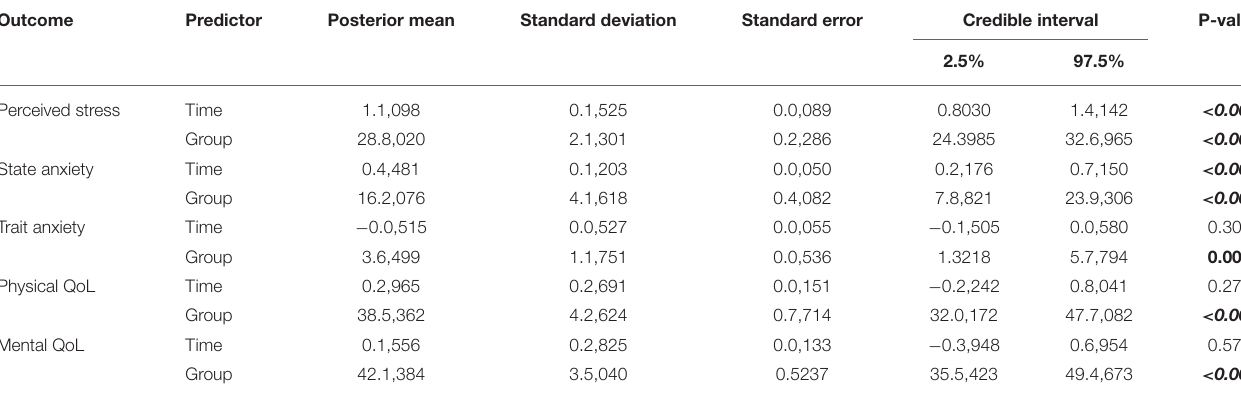
TABLE 2 | Effectiveness of family-centered empowerment model (FCEM) using the Bayesian multivariate mixed-effects model.